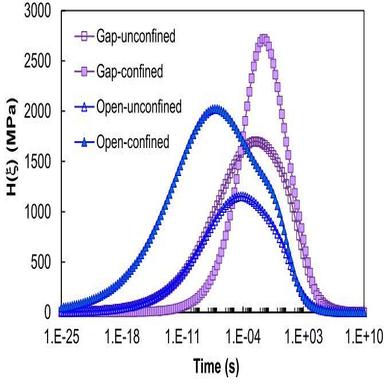
Relaxation spectra of the gap- and open-graded mixtures.